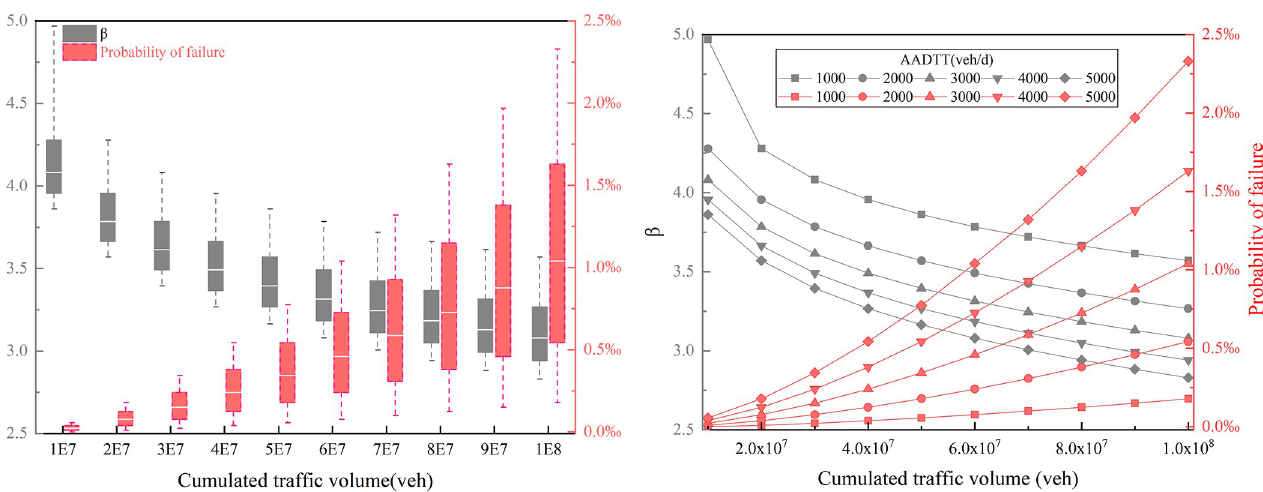
Fig 10. Influence of AADTT on risk (Car-Z2): (a) Difference in the influence of AADTT on reliability and probability of failure, (b) the influence of AADTT on reliability and probability of failure.